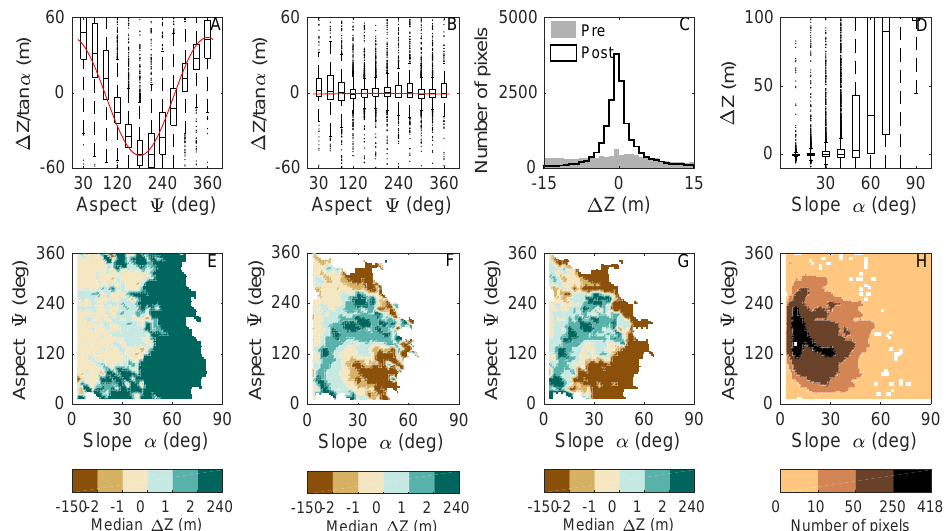
Figure 4. Results of data analysis and corrections of TanDEM30 relative to the ALS on SA ( A – E ) and applied to GA ( F – H ). ( A , B ): distribution of ∆ Ztan ( α ) vs. aspect Ψ before and after GC respectively; ( C ): ∆ Z histograms before and after GC; ( D ): variation of ∆ Z with slope of the surface. ( E – G ): heatmaps of median ∆ Z in slope-aspect ( α − Ψ ) domain binned in 1 ◦ α and 4 ◦ Ψ bins. ( E ): SA; ( F ): GA before slope/aspect correction; ( G ): GA after SAHC; The extreme values of the color scale correspond to maximum and minimum median ∆ Z across all three heatmaps. ( H ): 2D histogram of the slope and aspect distribution across the